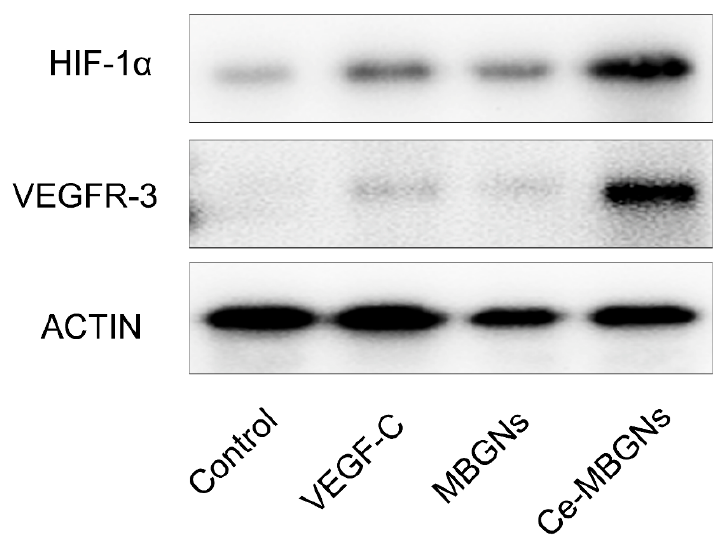
Figure 7. Western Blot results of LECs stimulated by VEGF-C (50 ng/mL), MBGN (extract of 1 wt/v%) and Ce-MBGN (extract of 1 wt/v%) for core HIF-1 α and VEGFR-3 markers.